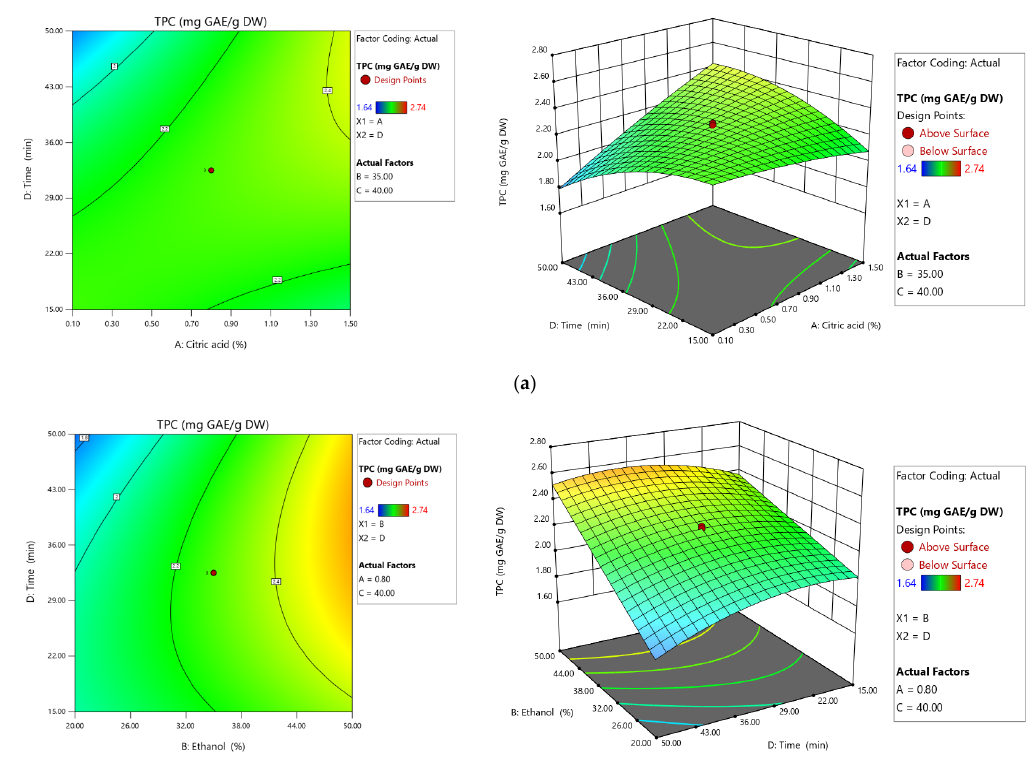
Figure 3. Second-order contour plots ( left ) and 3D surface plots ( right ) screening the effect of extraction time and citric acid concentration ( a ) and extraction time and ethanol ( b ) on the extraction yield of total phenolic content (TPC).